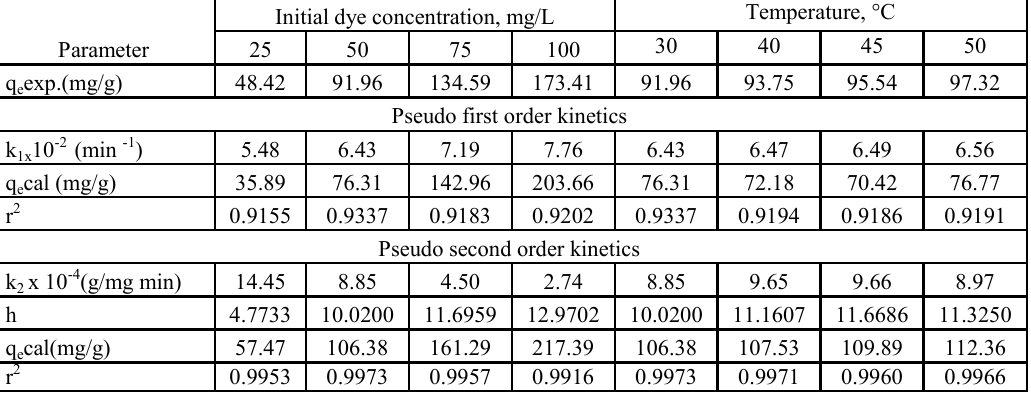
Table 3: Kinetic parameters for the adsorption of AV 49 onto